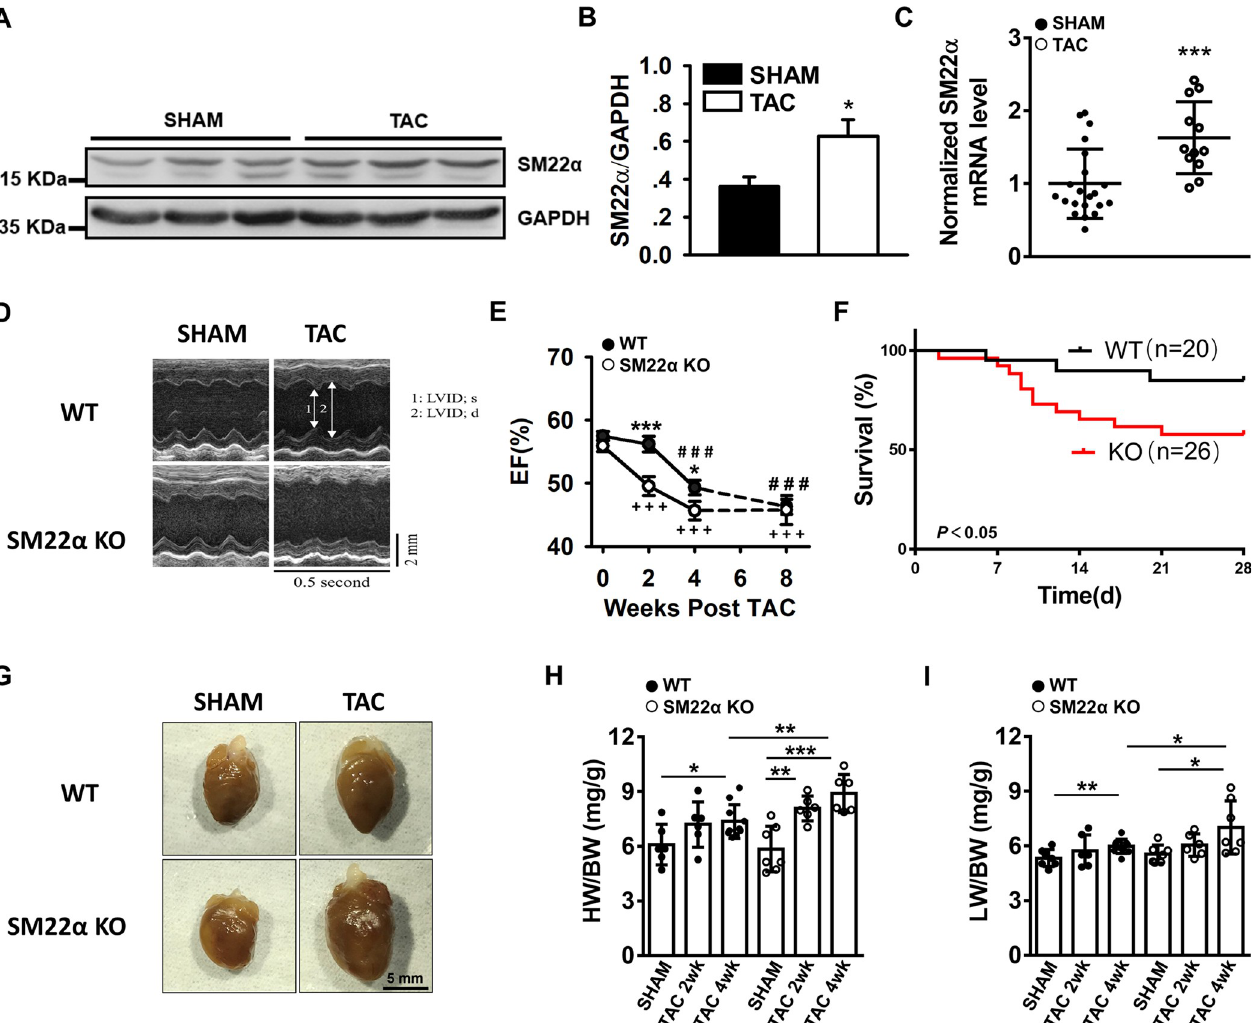
Fig 7. The disruption of SM22 α accelerates the development of heart failure induced by TAC. (A) Western blot of SM22 α in cardiomyocytes of WT mice sham and TAC hearts. (B) Bar graph showed increased level of SM22 α protein post TAC (n = 5 in each group). (C) qRT-PCR analysis of SM22 α mRNA (WT: n = 21; KO: n = 12). (D) Echocardiographic assessment of heart function using M-mode images of left ventricle. (E) Quantitative evaluation of systolic function in LV EF of 0, 2, 4 and 8 weeks post TAC (n = 35–40 per group). Data are presented as the mean ± SEM. � P < 0.5, ��� P < 0.001 vs. WT control for the same week, ### P < 0.001 vs. WT baseline, +++ P < 0.001 vs. SM22 α KO baseline. (F) Kaplan-Meier curve revealing increased mortality in SM22 α KO mice compared with WT mice after TAC (WT: n = 20; KO: n = 26). (G) Whole mount of representative hearts from WT and SM22 α KO sham or 4 weeks post TAC. (H, I) Heart weight to body weight ratio (HW/BW) (H) and lung weight to body weight ratio (LW/BW) (I) for WT and SM22 α KO mice 2 and 4 weeks post TAC or sham surgery (n = 6–10 per group). Data are represented as mean ± SEM. � P < 0.05, �� P < 0.01, ��� P < 0.001.